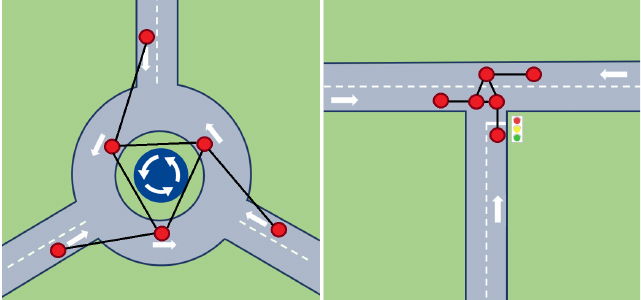
Figure 10: Possible three-road intersection discussed within the six-dot model. Both intersections share the same topology, but they differ for the imposed priority rules. In the roundabout, vehicles inside the ring have the priority over vehicles from the external arms; in the symmetric intersection, right-hand priority rule applies; in the priority intersection, vehicles in the secondary arm must give way to the vehicles from both major